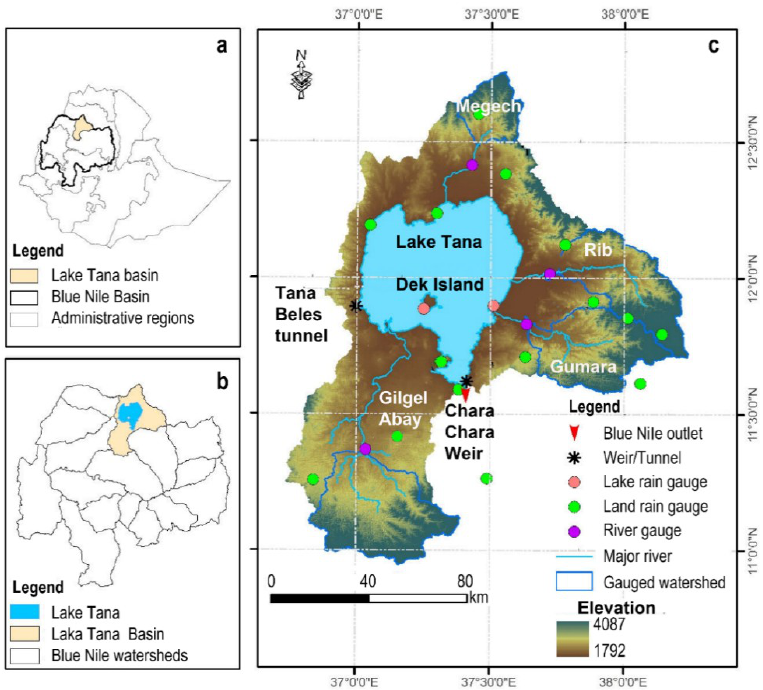
Figure 1. Maps of ( a ) Ethiopia with the Lake Tana basin in yellow; ( b ) Blue Nile basin with the Lake Tana basin in yellow and Lake Tana in blue; and ( c ) elevation map of the Lake Tana basin with two lake rainfall measuring stations, 13 rain land based stations within the Lake Tana basin.